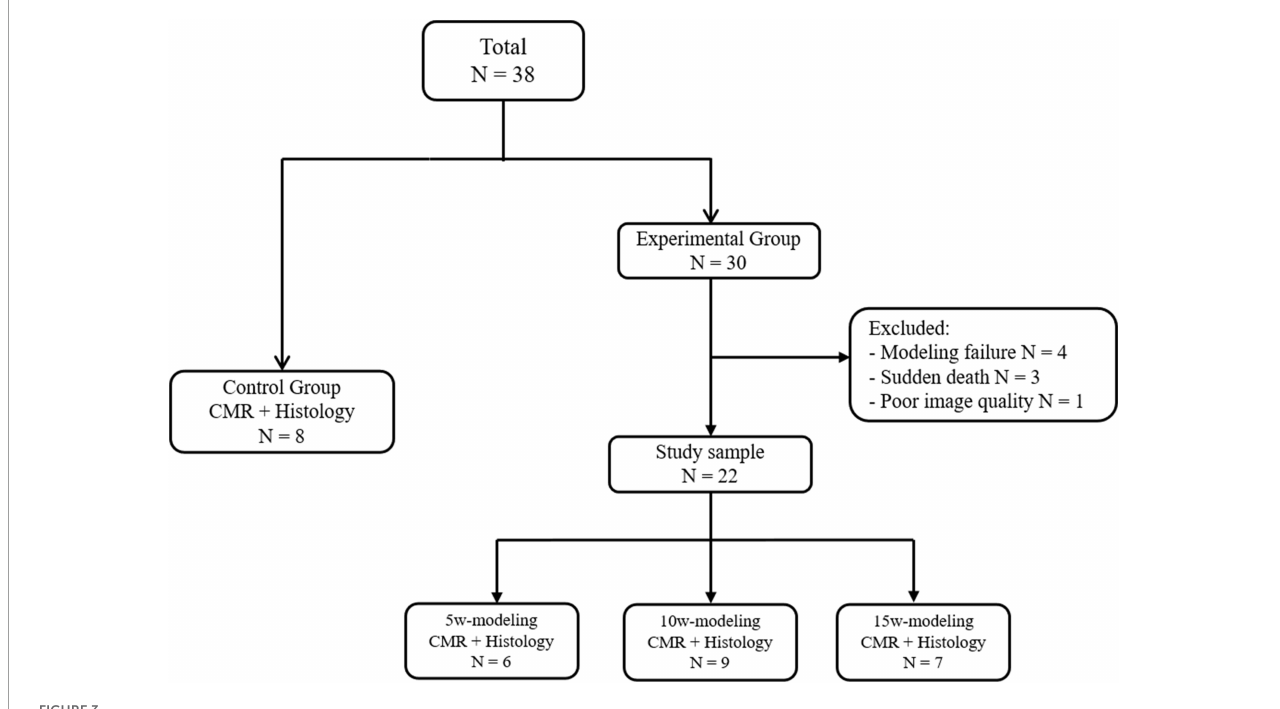
FIGURE3 Flowchart of the study design. CMR, cardiac magnetic resonance.